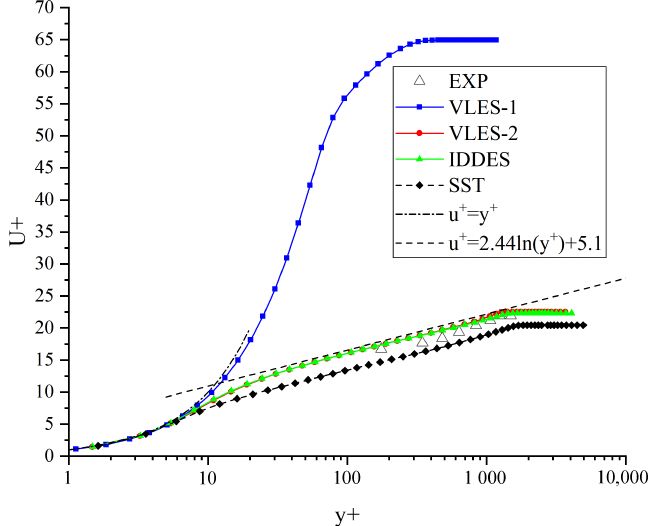
Figure 3. Comparisons of mean streamwise velocity profiles for the first section in the wall units.